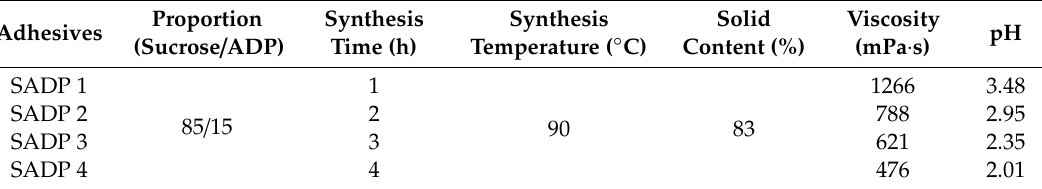
Table 1. Detailed information of SADP adhesives.